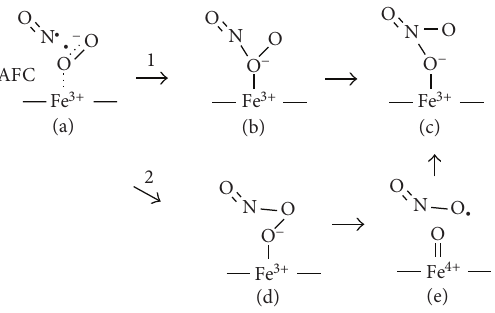
F 2: Two possible mechanisms and intermediates for O-atom rearrangement in the NO dioxygenation reaction. (1) shows the concerted Lewis acid mechanism in which NO attacks the proximal O-atom and iron facilitates O-O bond heterolysis through electron withdrawal. NO reacts with the antiferromagnetically coupled ( AFC ) ferric-superoxo (a) to form a transient ferric-peroxynitrite intermediate (b), which isomerizes to form the ferric-nitrato species (c). (2) shows the ferryl mechanism in which NO attacks the distal O-atom and iron facilitates O–O bond homolysis through electron withdrawal. e NO dioxygenation reaction generates a ferric- peroxynitrite intermediate (d) which weakens the O–O bond to intermediates (e) that homolysis forming “caged” ferryl and NO then combine to form the ferric-nitrato species (c) 2